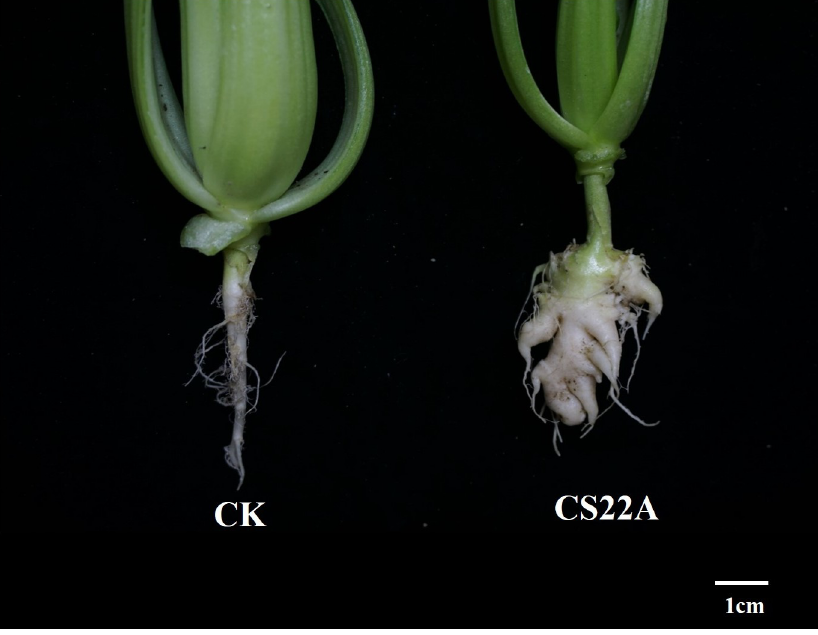
Fig 1. Clubroot symptoms of CS22. Plants were inoculated with the 7th physiology race of P . brassicae (CS22A), while the control was not subjected to pathogen inoculation.